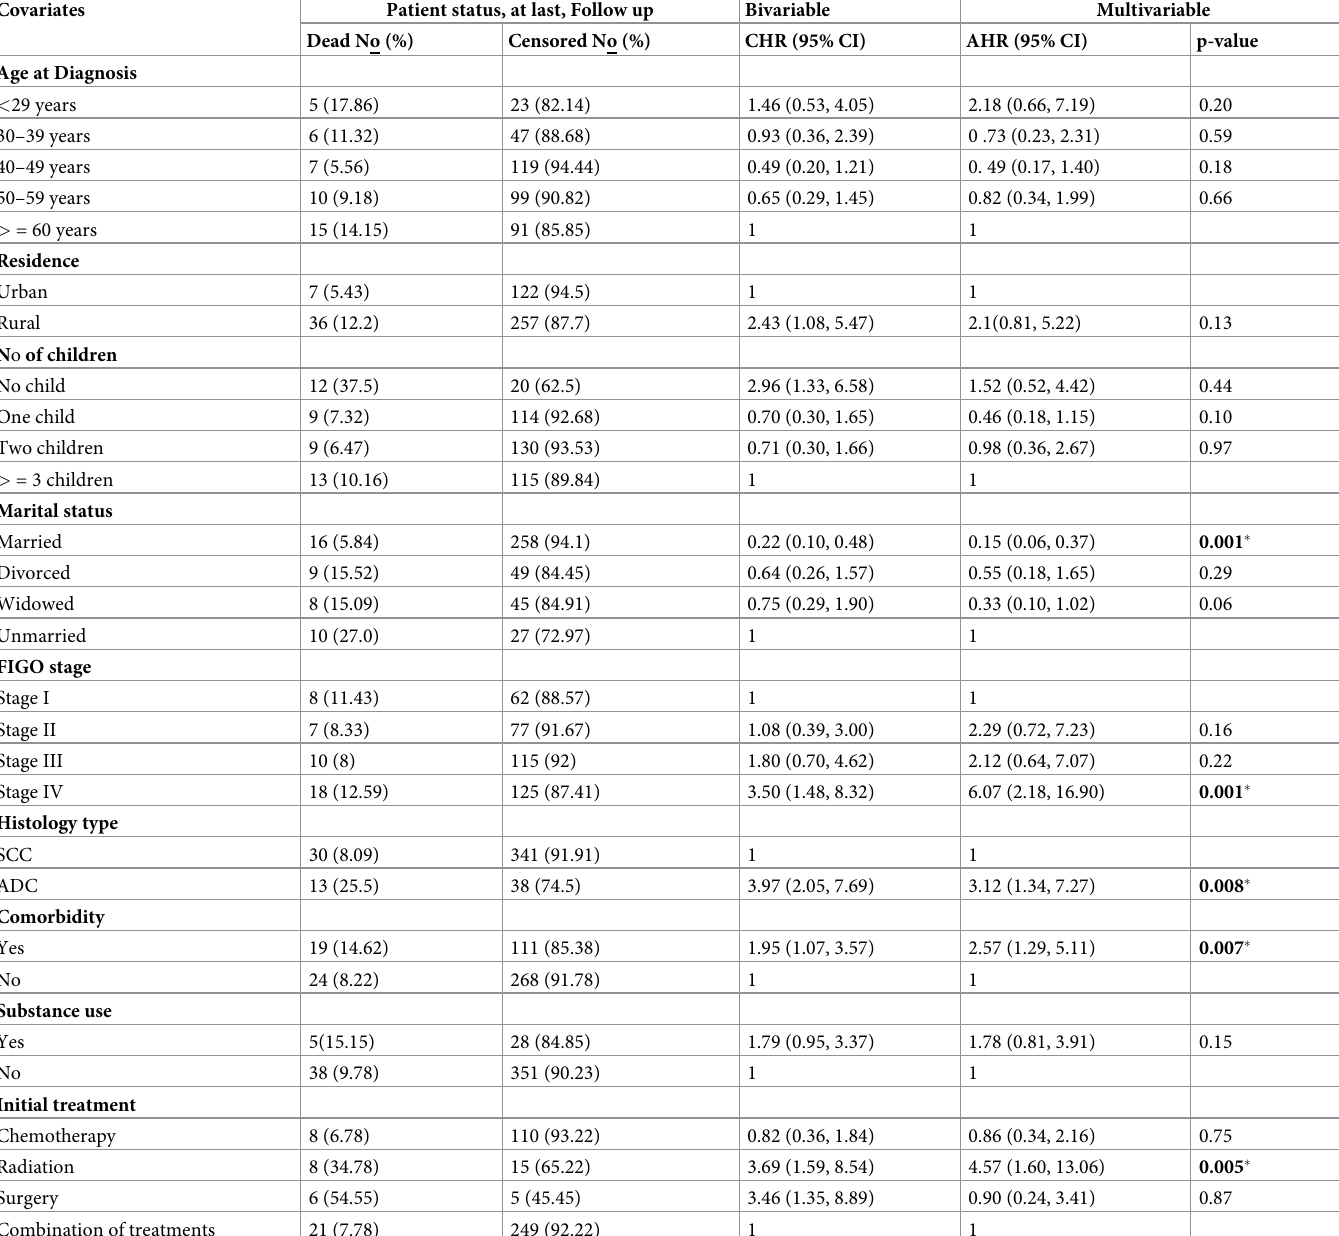
Table 7. Results of the bivariable and multivariable Cox regression analysis of cervical cancer patients at Felege Hiwot Comprehensive Specialized Hospital Oncol- ogy Center, Ethiopia (N = 422, March 2021). Covariates Patient status, at last, Follow up Bivariable Multivariable